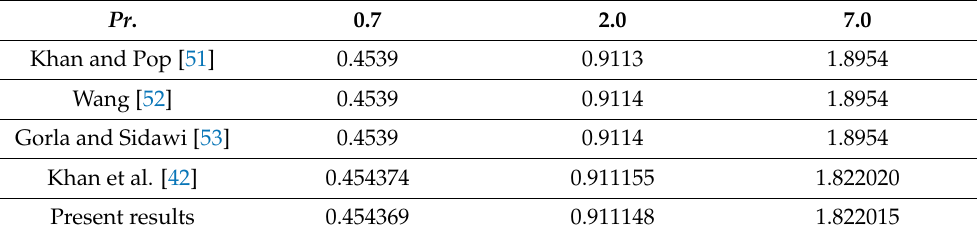
Table 2. An assessment − θ (cid:48) ( 0 ) for some reduced cases. Pr